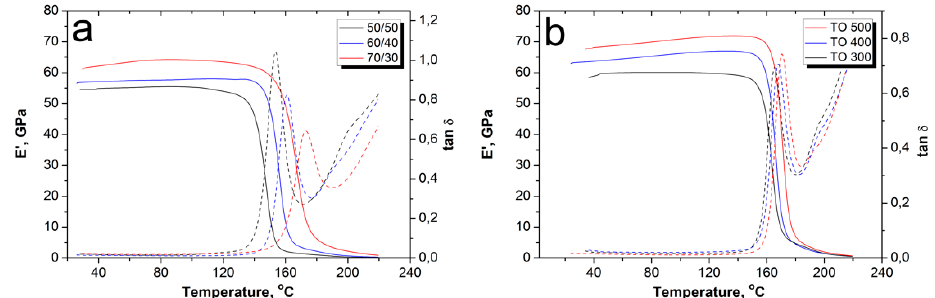
Figure 12. The DMA results of the CF / PSU composites (60 / 40 wt %) depending on the ( a ) initial fiber content and the ( b ) fibers’ surface modification regime.